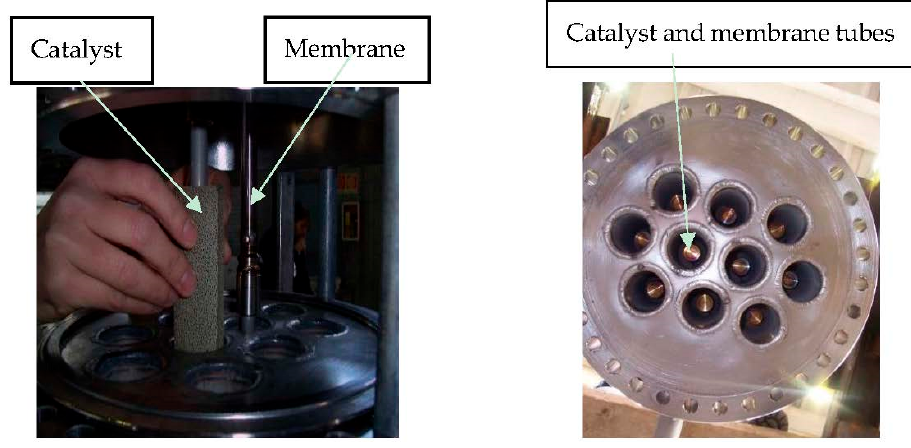
Figure 4. R-02 reactor membrane arrangement.